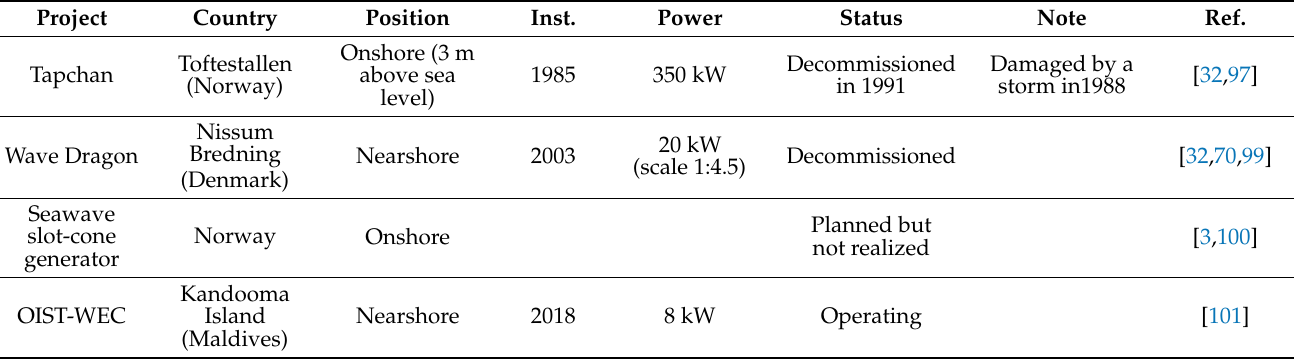
Figure 32. Schematic of the improved design of the Ducted OIST-WEC [101]. Table 5. Summary of the main OD